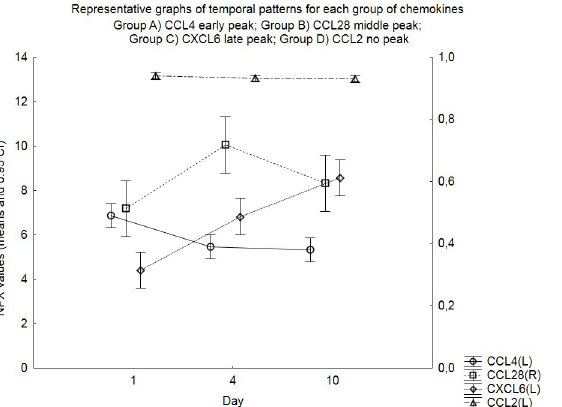
Fig 1. Representative graphs of temporal pattern of expression for each group of chemokines: Four different temporal patterns of expression were noticed, and the chemokines were grouped accordingly. Representative graphs for each chemokine group are illustrated with their means and 0.95 CI for each day. More specifically, CCL4 is shown for Group A with its early peak and decreasing trend; CCL28 was the only chemokine of Group B with a significant middle peak on day 4; CXCL6 with its increasing trend and late peak is shown for Group C; and finally, CCL2 is representing Group D with stable values throughout the observation period. Note that NPX values of CCL4 (representing Group A), CXCL6 (Group C) and CCL2 (Group D) are shown on the left Y-axis (L) whereas values of CCL28 (representing Group B) are shown on the right Y-axis (R).